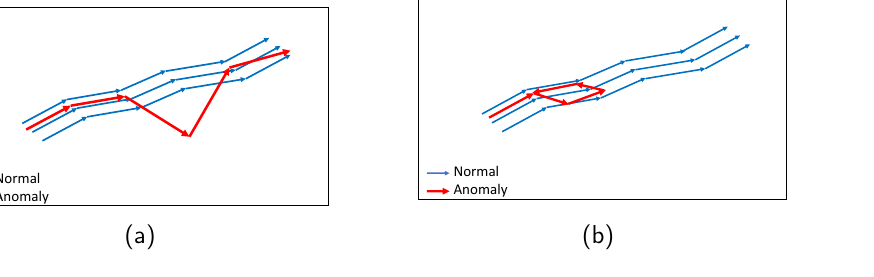
Figure 1. Illustration of anomalous trajectory types: ( a ) Rare location visit anomaly. ( b ) Detour anomaly. ( c ) Random route